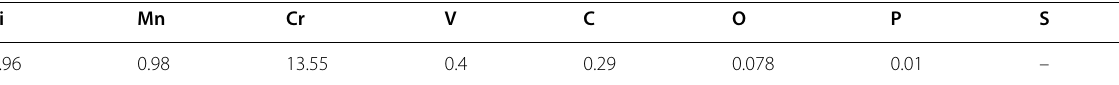
Table 1 Chemical composition (wt%) of S136 powder